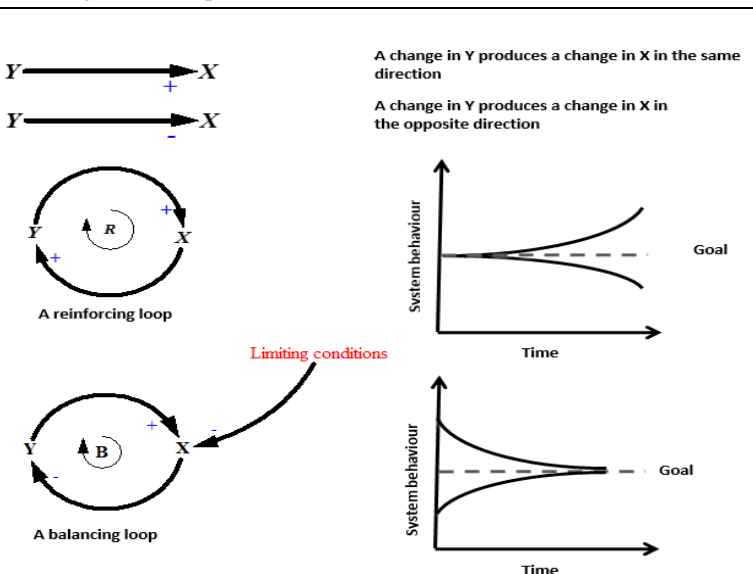
Figure A1. The features of simple “balancing” and “reinforcing” loops adopted from [39].